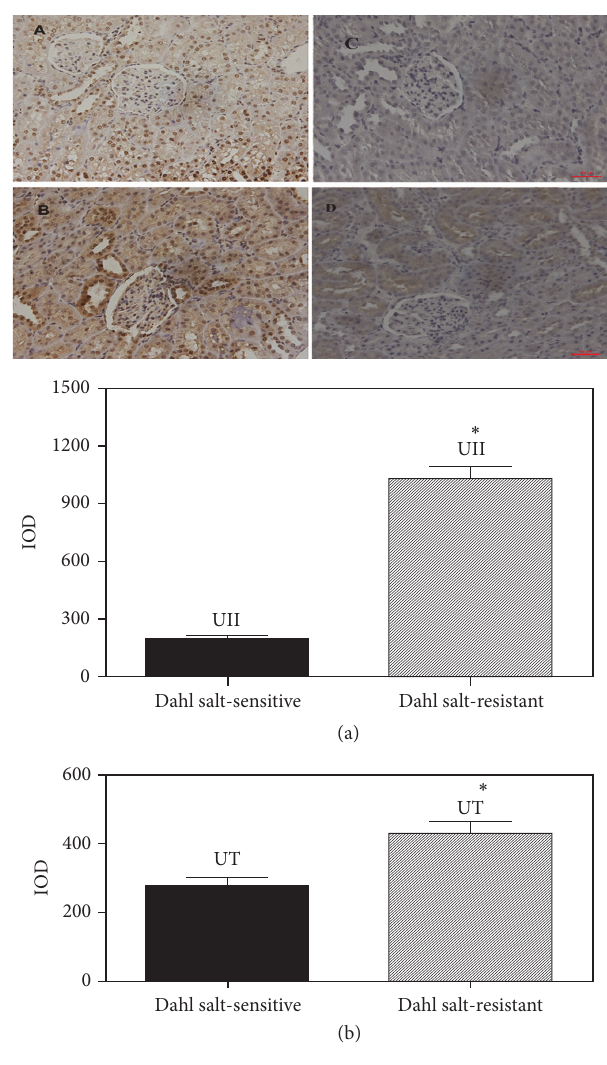
Figure 3: Figure 3 showed analysis of immunohistochemistry for UII (A and B) and UT expressions (C and D) in kidney tissue in SS and SR rats. The expressions of UII and UT were present predominantly in renal tubular epithelium and less in glomerulus (A, B, C, and D). ∗ 𝑃 < 0.01 versus IOD of SS rats (a and